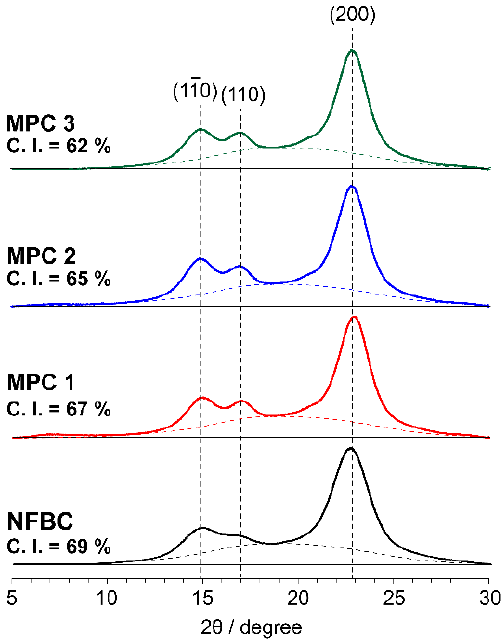
Nanomaterials 2022 , 12 , 537 Figure 3. X ‐ ray diffraction (XRD) patterns of MPC 1–3 and NFBC. Figure 3. X-ray diffraction (XRD) patterns of MPC 1–3 and NFBC.